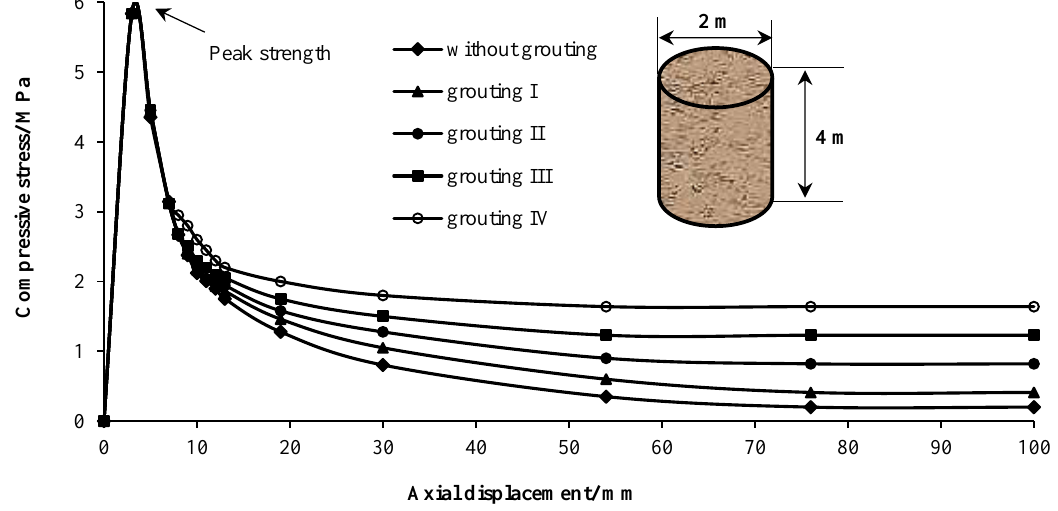
Figure 12. Stress-strain curves of different grouting schemes.